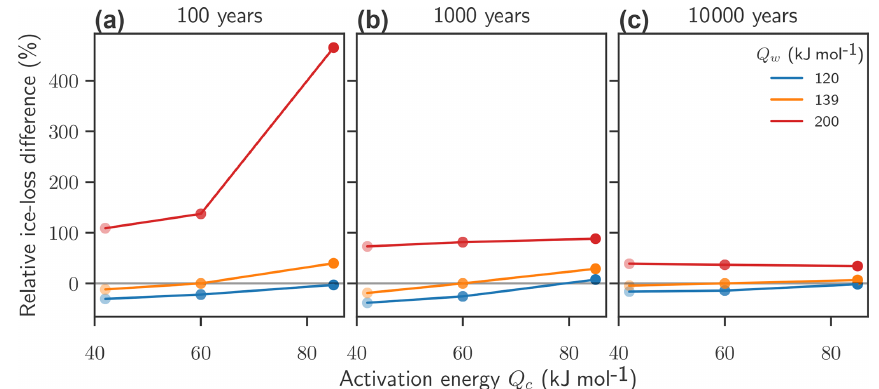
Figure 12. Effect of activation energy on flow-driven ice discharge under 2 ◦ C warming, including sliding: relative difference of flow- and sliding-driven ice loss after 100 (a) , 1000 (b) , and 10000 (c) years. The simulations have reached a new equilibrium after 10000